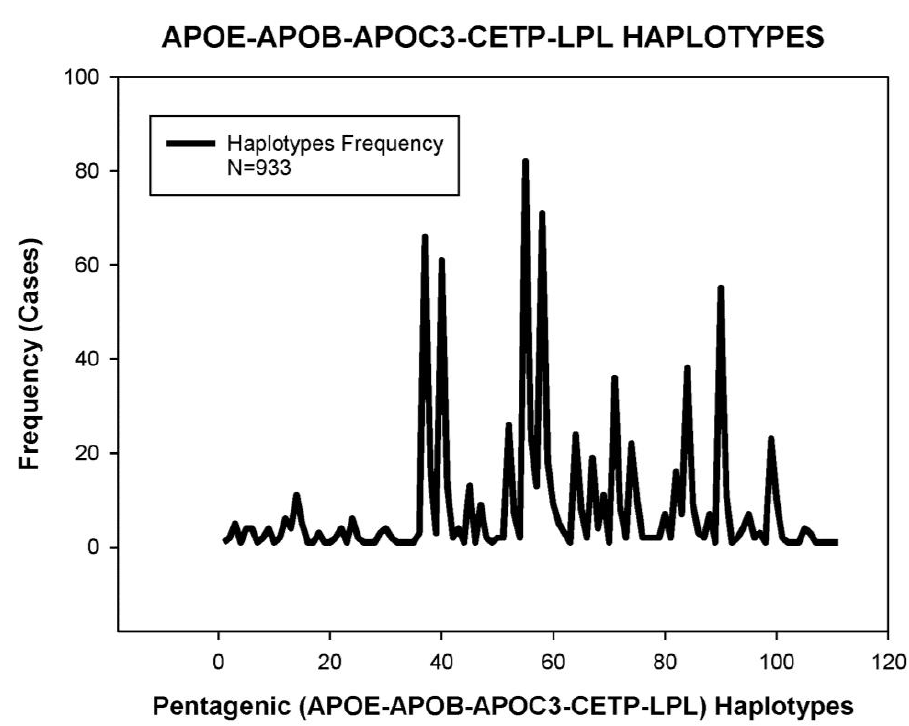
Figure 5. Distribution and frequency of pentagenic haplotypes integrating APOE , APOB , APOC3 , CETP , and LPL genotypes in patients with Alzheimer’s disease.